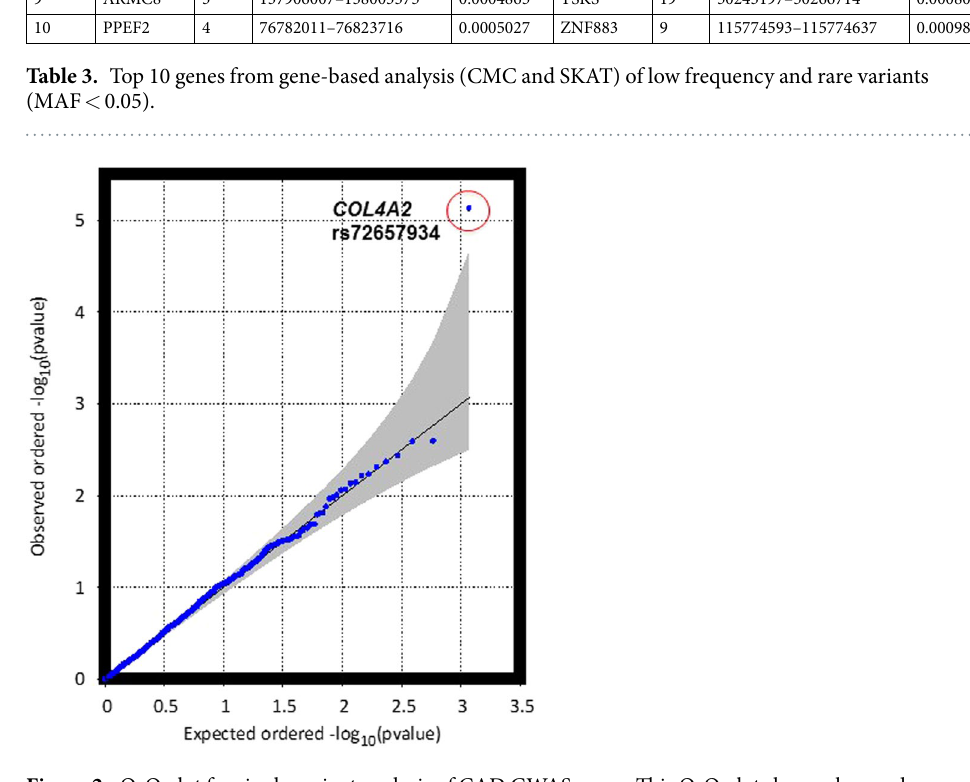
Figure 2. Q-Q plot for single variant analysis of CAD GWAS genes. This Q-Q plot shows observed versus expected ordered − log 10 (p) values for single variant analysis of CAD GWAS genes (MAF > 0.01), with the shaded region showing standard